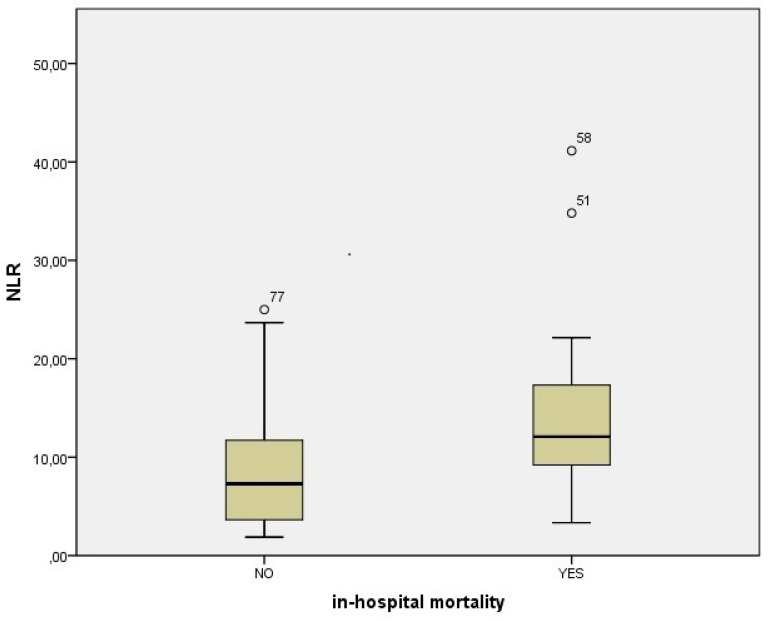
Comparison of neutrophil to lymphocyte ratio (NLR) between survivor and non-survivor patients admitted with type A acute aortic dissection.